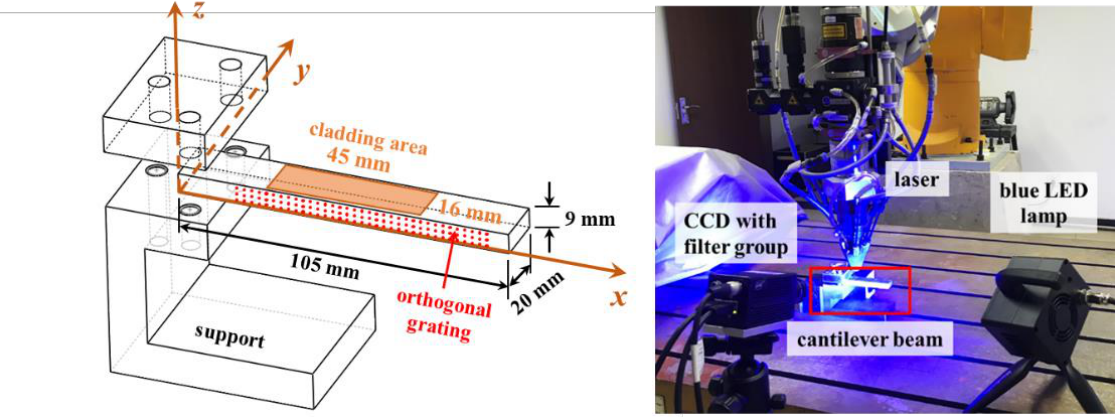
Figure 3. Cantilever for online deformation measurement